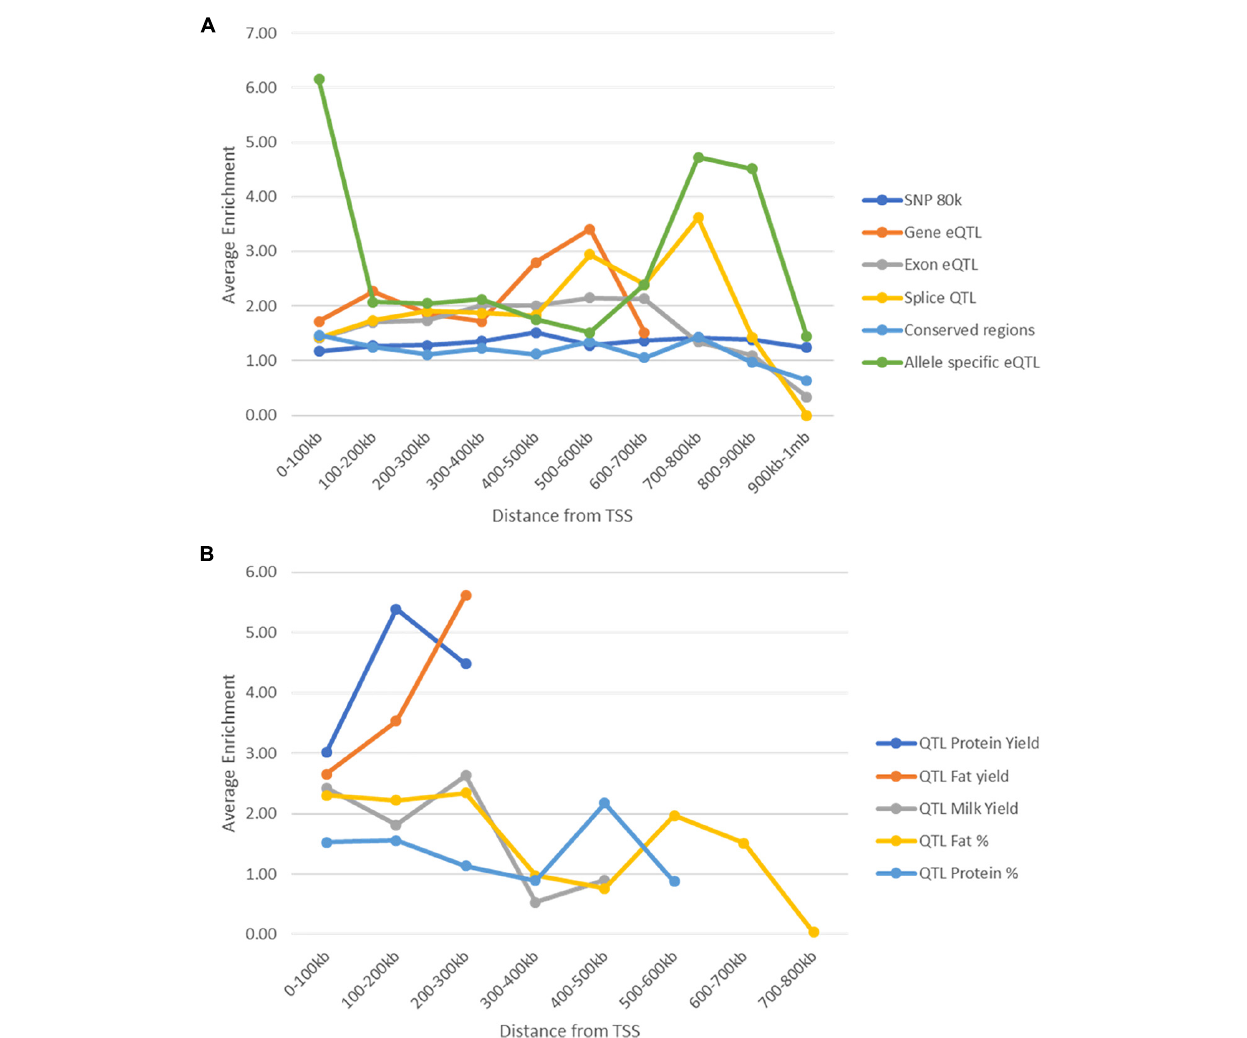
FIGURE 9 | Enrichment of SNPs within peaks by distance to the nearest transcription start site. (A) Enrichment (averaged across all animals, tissues, and marks) of SNPs within peaks at different distances from transcription start sites. Enrichment stays above 1 in all cases until 800 kb from the nearest transcription start site. (B) Enrichment (averaged over all tissues and animals) of milk production QTL within peaks at different distances from transcription start site. Enrichment was not calculated for protein and fat yield more than 300 kb from a TSS as there were less than 10